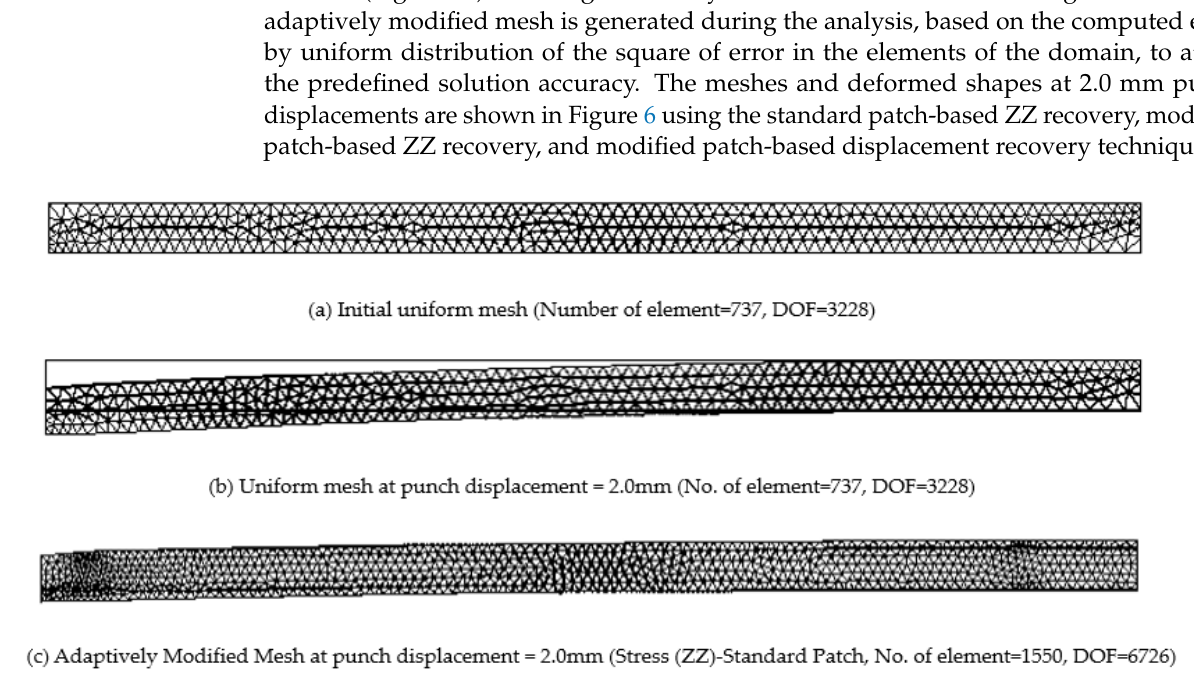
Figure 6. Adaptively modified meshes in sheet stretching problem using stress/displacement recovery and patch configura- tion (triangular elements initial mesh = 737, with 14% target